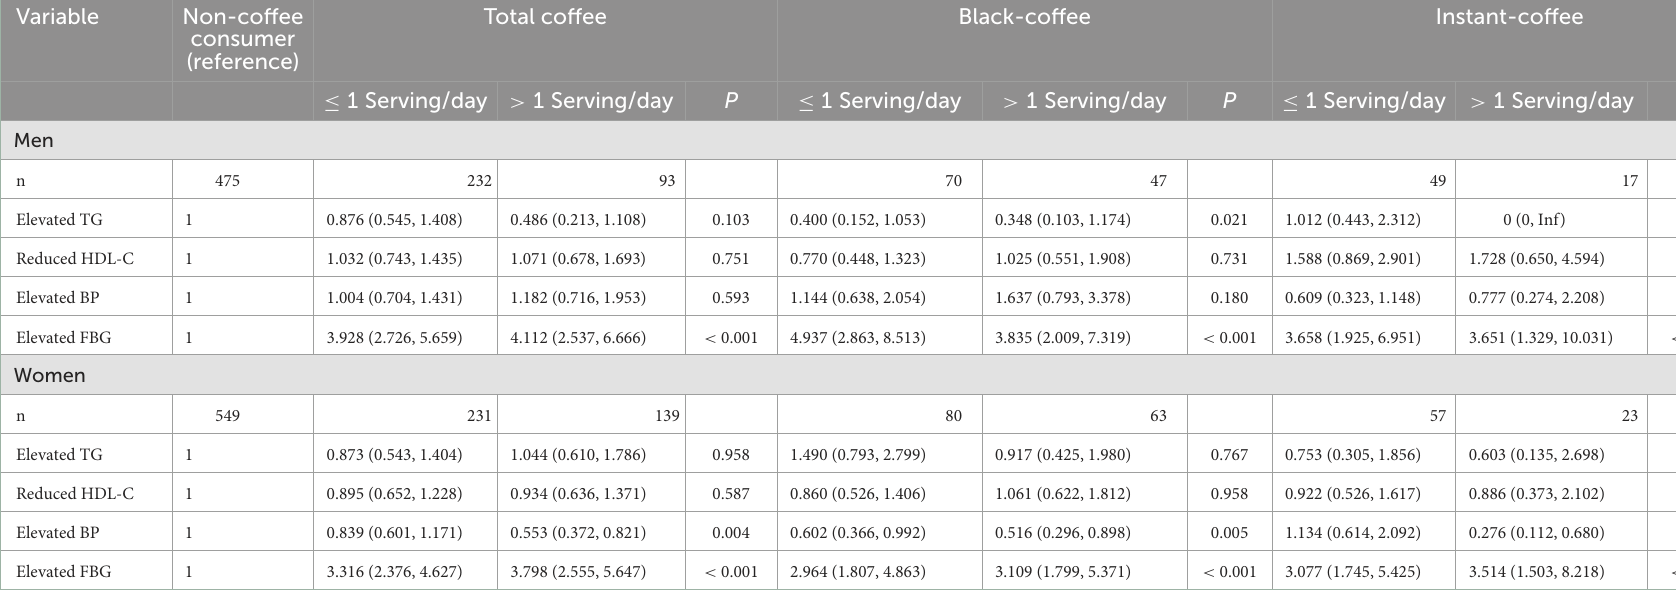
TABLE 3 Multivariable-adjusted odds ratios and 95% CIs for metabolic components according to daily servings of coffee (by gender). Variable Non-coffee Total coffee Black-coffee consumer (reference)